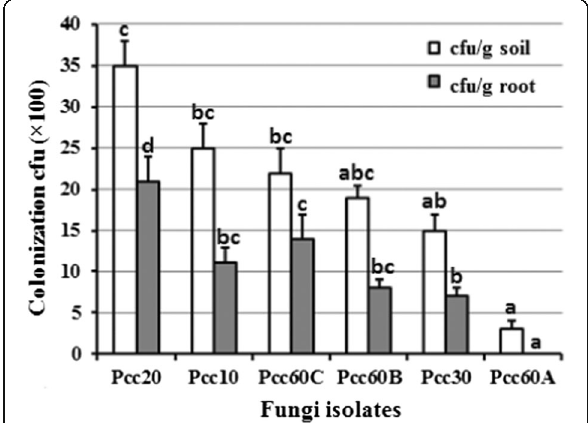
Fig. 1 Numbers of colony-forming units (cfu) of P. chlamydosporia var. chlamydosporia isolates by the end of experiment, in soil and rhizosphere of pistachio. Columns with similar letters are not signifi- cantly different at 5% live based on LSD test. Pcc10, Pcc20,